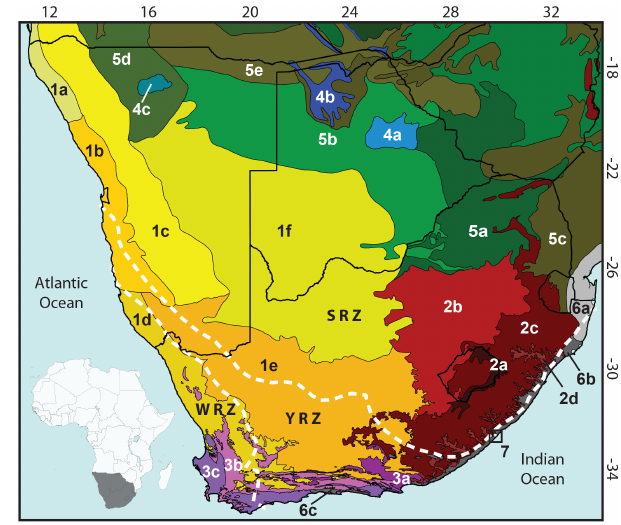
Figure 3. Distribution of the southern African biomes and ecore- gions (Olson et al., 2001): (1) deserts and xeric shrublands – (1a) Kaokoveld Desert, (1b) Namib Desert, (1c) Namibian savanna woodlands, (1d) Succulent Karoo, (1e) Nama Karoo, (1f) Kala- hari xeric savanna; (2) montane grasslands and shrublands – (2a) Drakensberg altimontane grasslands and woodlands, (2b) High- veld grasslands, (2c) Drakensberg montane grasslands, woodlands and forests, (2d) Maputaland–Pondoland bushland and thickets; (3) Mediterranean forests, woodlands and scrub – (3a) Albany thick- ets, (3b) montane fynbos and renosterveld, (3c) lowland fynbos and renosterveld; (4) flooded grasslands and savannas – (4a) Zam- bezian halophytics, (4b) Zambezian flooded grasslands, (4c) Etosha Pan halophytics; (5) tropical and subtropical grasslands, savan- nas and shrublands – (5a) southern Africa bushveld, (5b) Kalahari Acacia-Baikiaea woodlands, (5c) Zambezian and Mopane wood- lands, (5d) Angolan Mopane woodlands, (5e) Zambezian Baikiaea woodlands; (6) tropical and subtropical moist broadleaf forests – (6a) Maputaland coastal forest mosaic, (6b) KwaZulu–Cape coastal forest mosaic, (6c) Knysna–Amatole montane forests; (7) man- groves . The dashed white lines delineate the different rainfall zones as defined by Chase and Meadows (2007): the winter rainfall zone (WRZ; > 66% winter rain), the summer rainfall zone (SRZ; < 33% of winter rain) and the year-round rainfall zone (YRZ) in be-